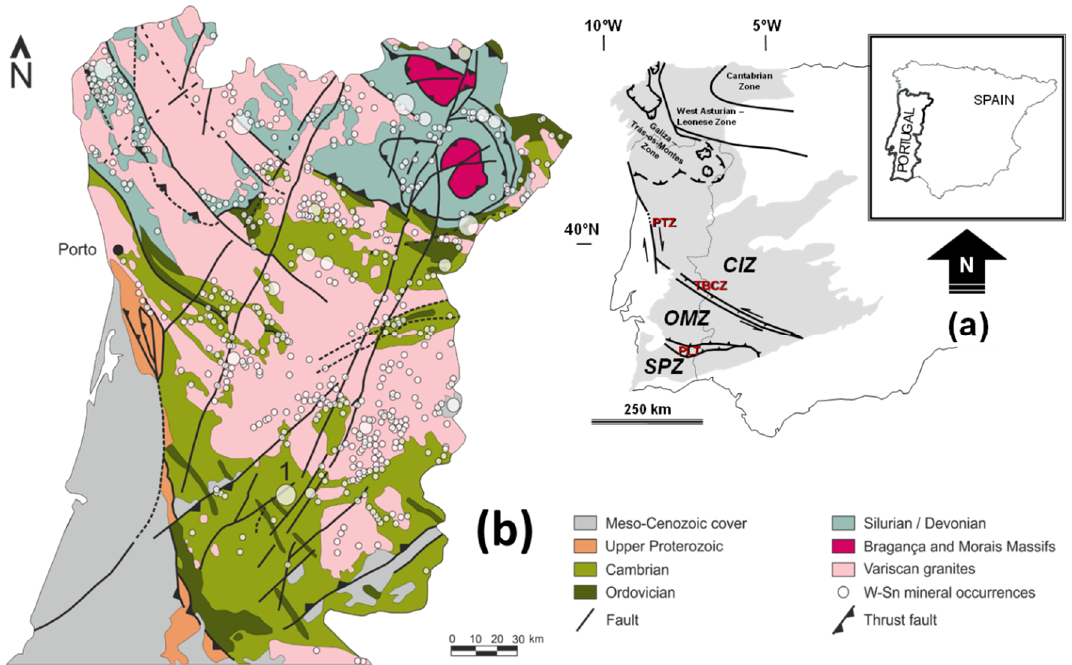
Figure 1. ( a ) Schematic illustration of the main geotectonic units in the Iberian Variscides and some major shear zones: CIZ—Central Iberian Zone; OMZ—Ossa–Morena Zone; SPZ—South Portuguese Zone; PLT—Pulo do Lobo Terrane (contiguous to the SW Iberian suture); PTZ—Porto–Tomar Shear Zone; TBCSZ—Tomar–Badajoz–Córdoba Shear Zone. ( b ) Simplified geological map of central and